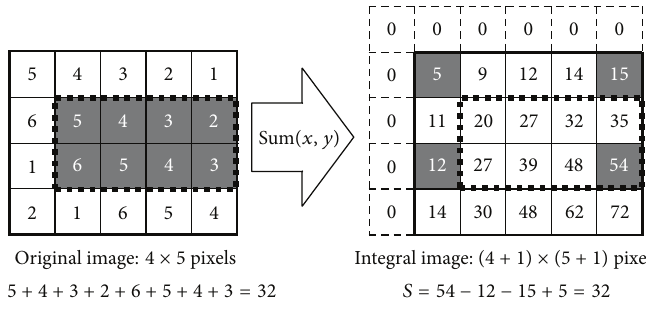
Figure 5: Pixel configurations for the original image and its integral